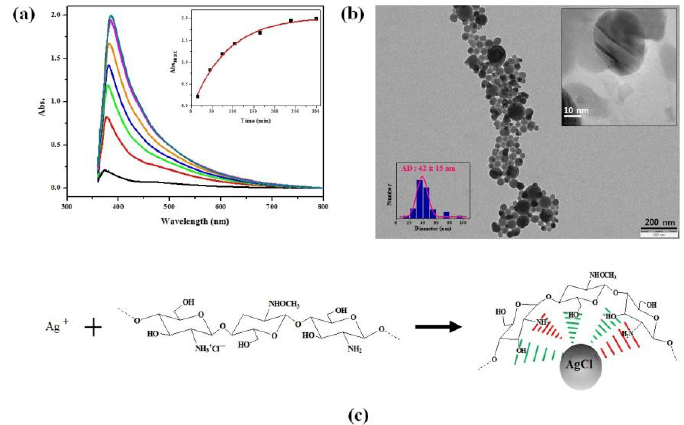
Figure 1. ( a ) UV-Vis spectra of CHI-AgCl NPs dispersion with reaction time (the inset shows the change in absorbance at 400 nm with reaction time); ( b ) TEM image and the corresponding particle size distribution (inset) of the CHI-AgCl NPs; and ( c ) a proposed mechanism for the formation of CHI-AgCl